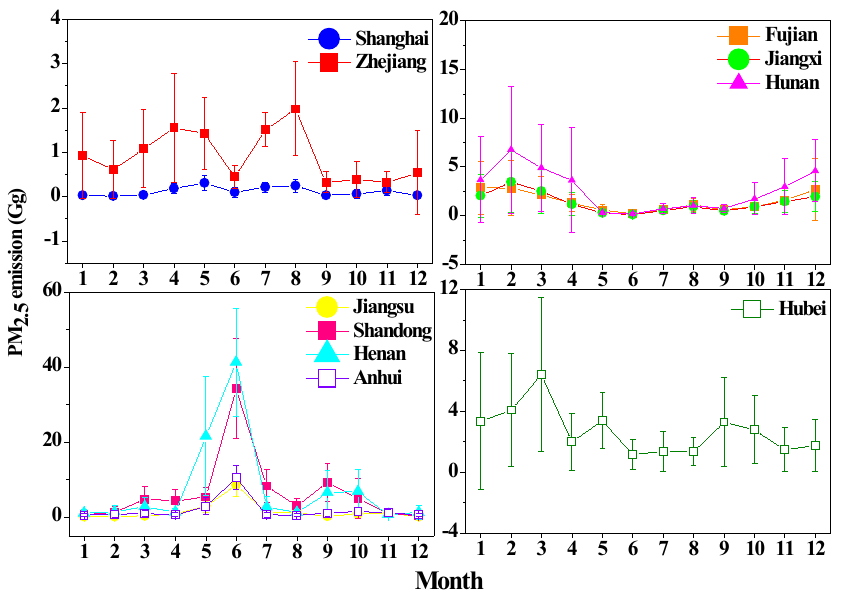
Figure 9. The monthly PM 2 . 5 emissions from open biomass burning in each